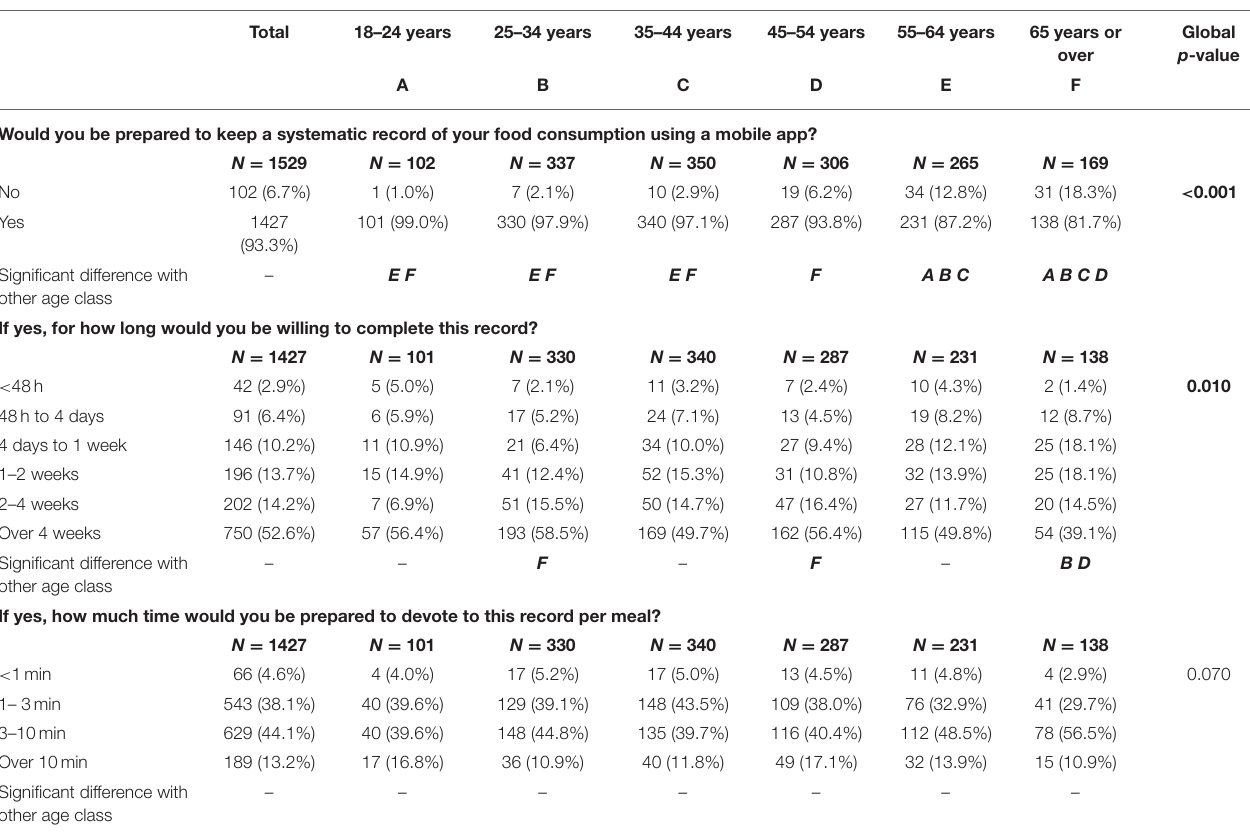
TABLE 6 | Tracking of food consumption in clinical research by age